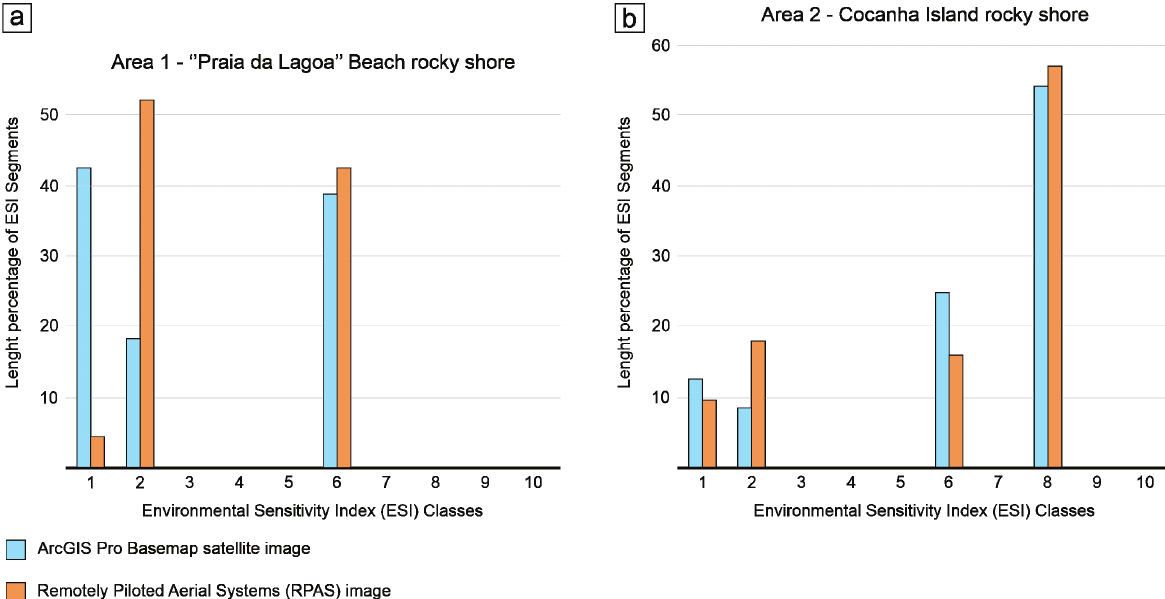
Figure 6. Percentage of ESI regions for Remotely Piloted Aerial Systems (RPAS) and ArcGIS Pro Basemap satellite images (a - Area 1, “Praia da Lagoa” Beach rocky shore; b - Cocanha Island rocky shore). Each bar on the graph represents a percentage of length (of the total length of the rocky shores) for each ESI